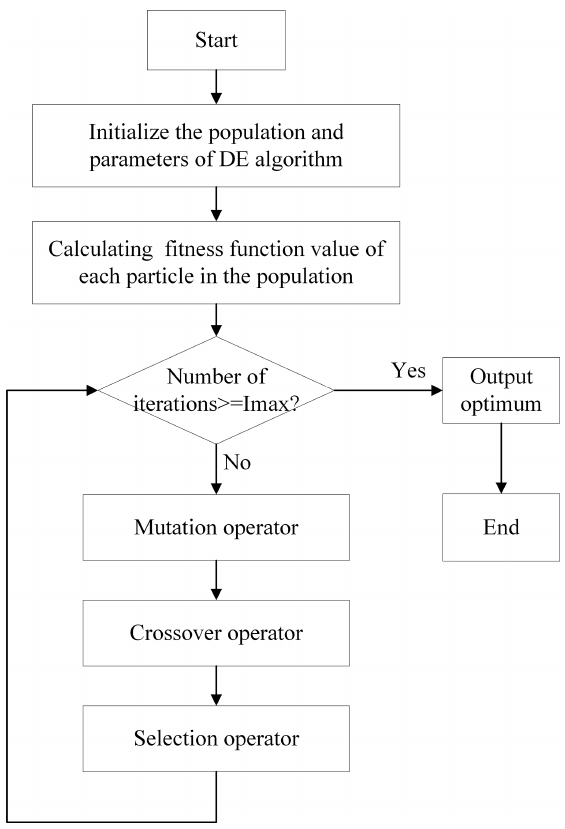
Figure 7. Flowchart of the Differential evolution